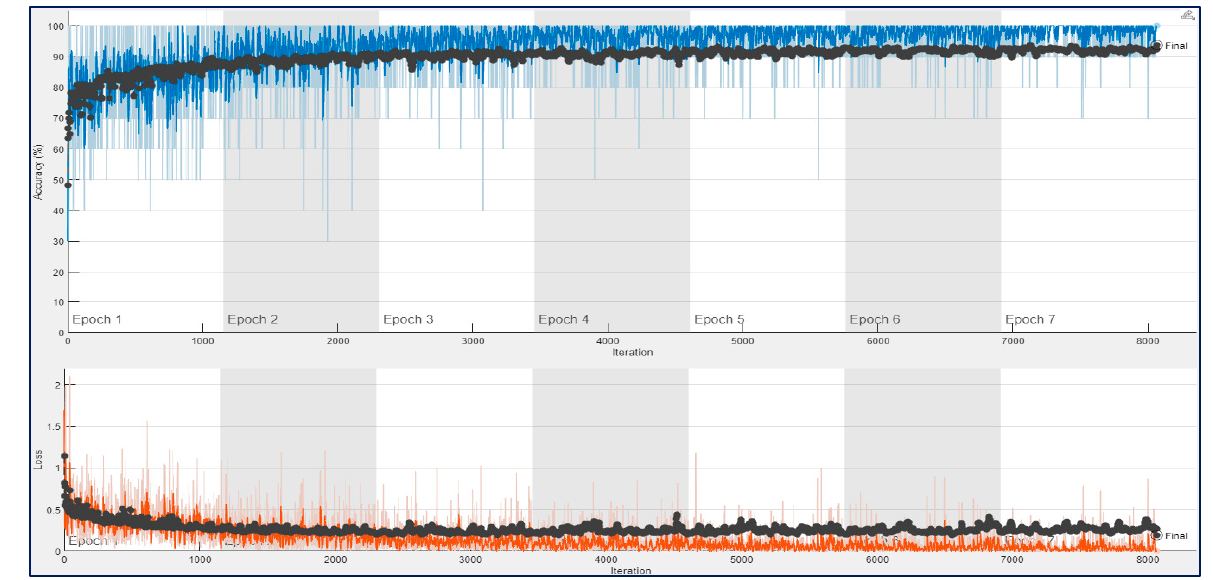
Figure 10. Training process result for ConvMixer with 12,800 spectrogram images in a trial on the 10 ‐ FCV.